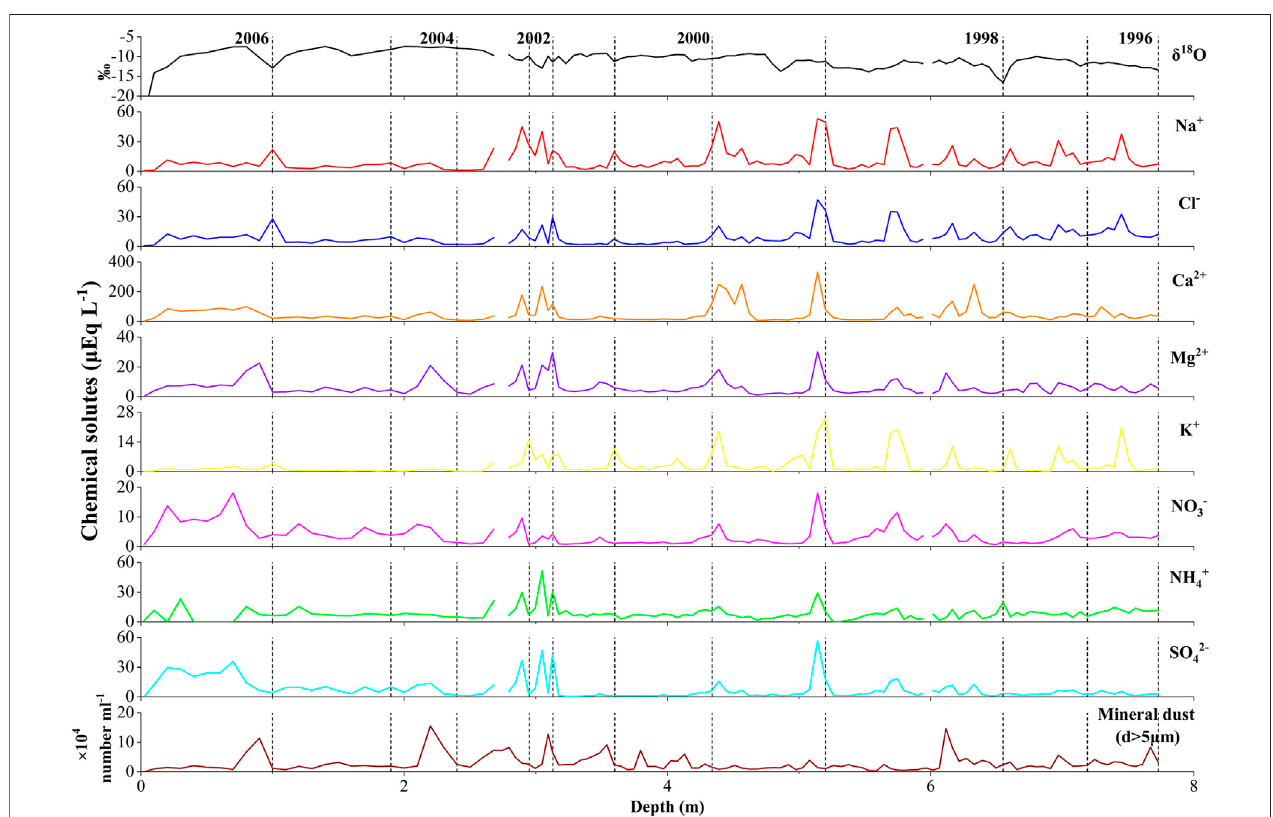
FIGURE 3 | Pro fi les of oxygen stable isotope, concentrations of major chemical solutes and mineral dust in a snow pit and ice core from the accumulation area of the glacier (Core B). Dashed line represents de fi ned years.